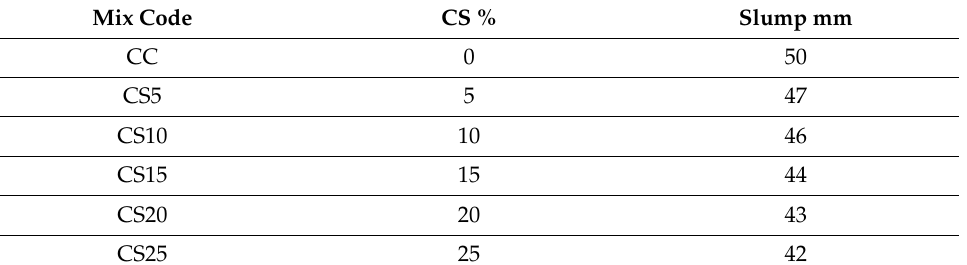
Table 2. Slump of CS concrete.